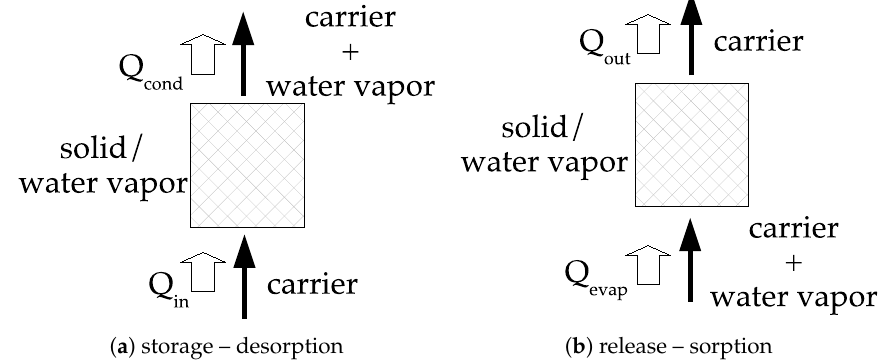
Figure 5. Open heat storage system—quantities refer to Figure 3—reproduced from [1], copyright permission: Elsevier,